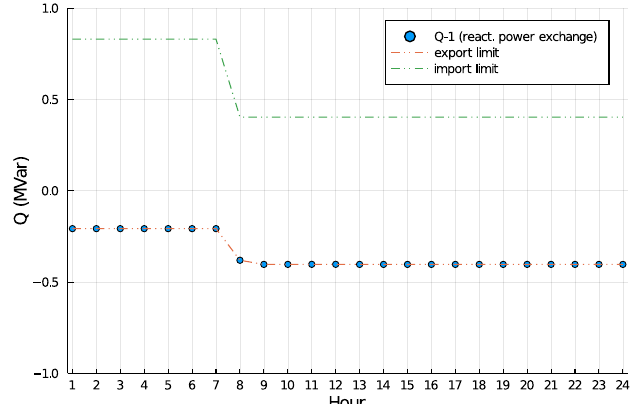
Figure 13. Reactive power exchange with the transmission system for the entire day when the proposed method is